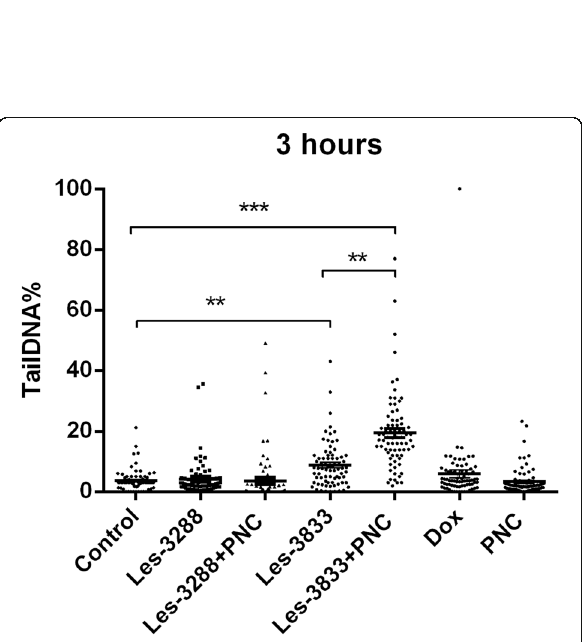
Fig. 13 DNA damage evaluated using the % of DNA in comet tail of C6 rat glioma cells treated with experimental antineoplastic compounds during 3 h at a concentration of 0.5 μ g/mL. * P ≤ 0.05; ** P ≤ 0.01; *** P ≤ 0.001. PNC, polymeric nanocarrier; Dox, doxorubicin (positive